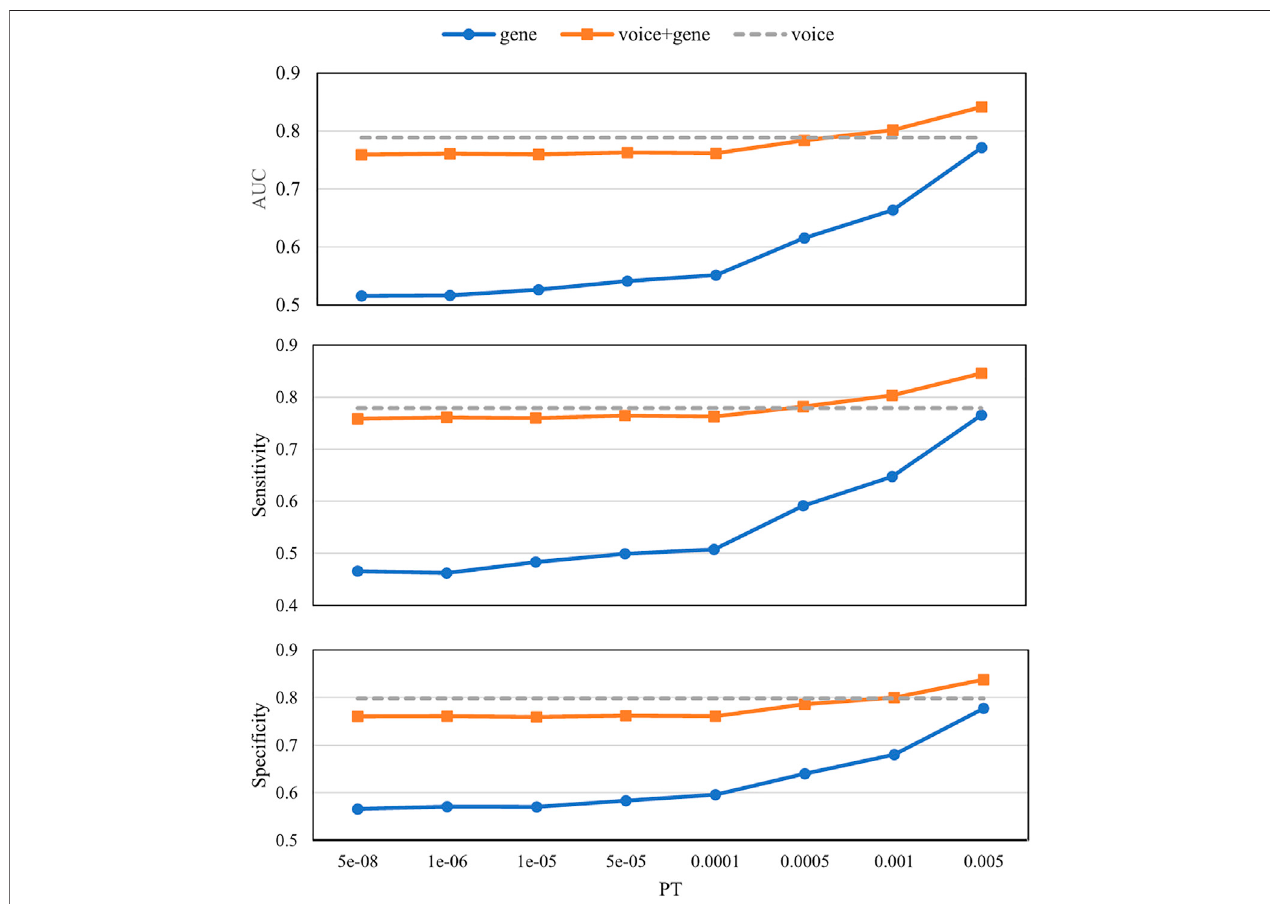
FIGURE4| Predictionresultswithdifferent p -valuethresholds(PTs)usingdifferentbiomarkers.The x -axisisthe p -valuethreshold(PT)usedinthegenemodeland the combined biomarkers. Voice biomarkers are not related to PT and are indicated by a dashed horizontal line . AUC, Area under the receiver operating characteristic